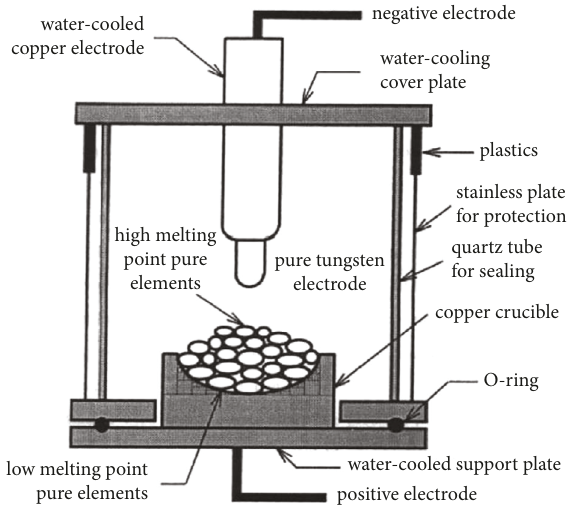
Figure 1: Schematic representation of arc melting process [10].